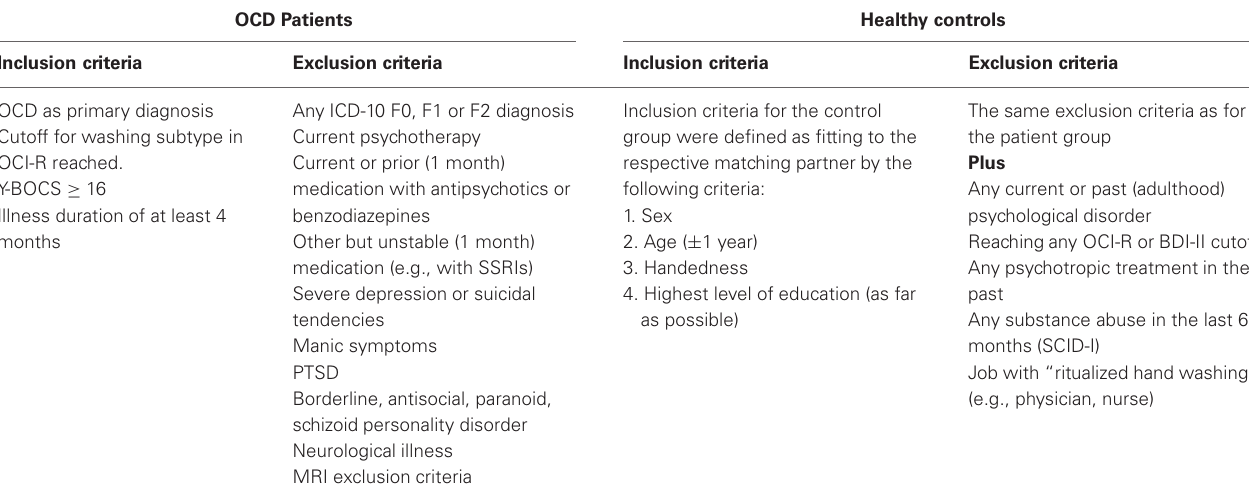
Table 1 | Overview of all inclusion and exclusion criteria for patients and healthy